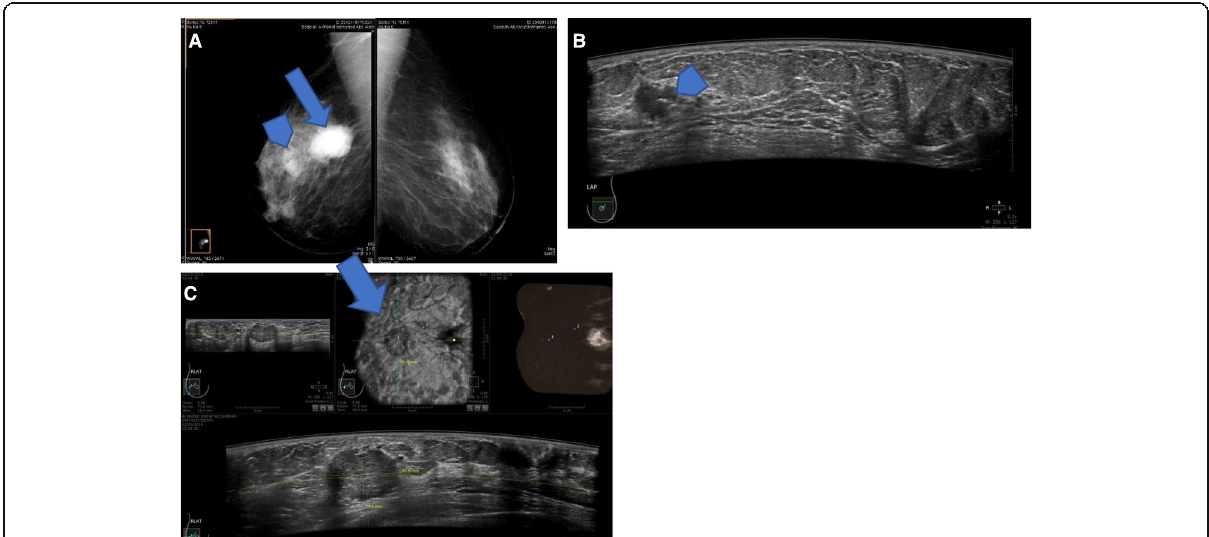
Fig. 3 a Left mammogram shows two lesions, one well defined at 12 o ’ clock (arrow) and the other is ill-defined opacity at 1 o ’ clock (arrow head). b , c Lesions proved by ABUS in different planes with 3D image to be a solid ovoid lesion typical for fibroadenoma (arrow) and the other is a malignant-looking mass lesion (arrow head BIRADS